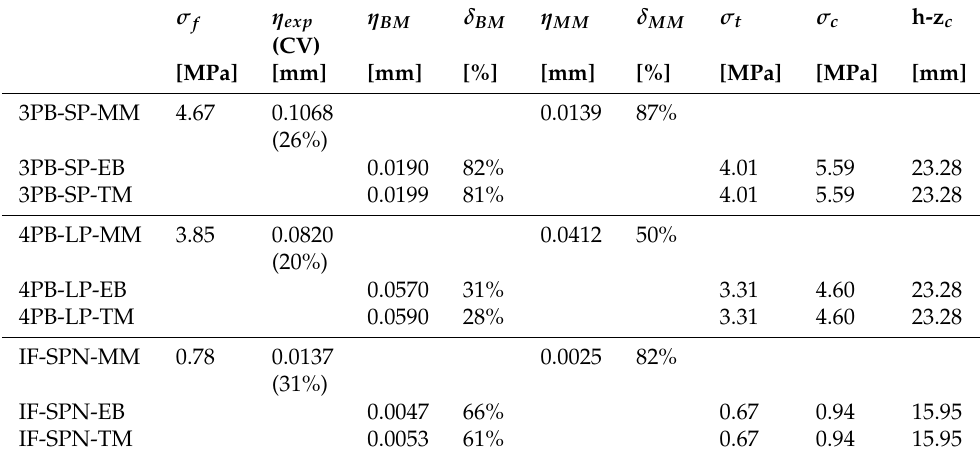
Table 8. Results of the mono-modulus (MM) and bi-modulus model (EB for Euler–Bernoulli and TM for Timoshenko beam model) applied to three-point (3PB-SP and IF-SPN) and four-point (4PB-LP) bending tests using n = E t / E c = 0.52. The flexural stress value σ f , vertical displacement of the load application point η exp , the vertical displacement retrieved by bi-modulus models η BM , the percentage difference between the displacements δ BM , the vertical displacement retrieved by mono-modulus model η MM , the percentage difference between the displacements δ MM , the maximum values of the tensile and compressive stress σ t σ c and the position of the neutral axis h-z c are reported for each bending